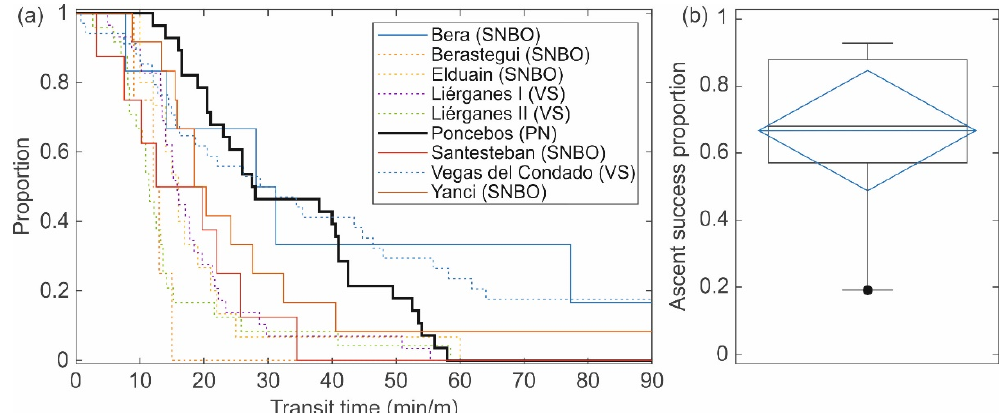
9 of 18 Figure 3. Numerical simulation of the fishway. ( a ) Pool depth of 1.8 m. ( b ) Pool depth of 5 m; dotted red line indicates the depth of 1.8 m. 3.2. Fish Response Regarding the comparisons between the two fish groups, there were no significant differences in biometric characteristics (Table 2) nor in the passage metrics (attempt per- centage, passage success, height exceeded, and transit time p -values = 0.463, 0.602, 0.568, and 0.949, respectively). Considering this, to study the following relations and increase the number of data, both groups were merged and analyzed together. The attempt percentage was 86% (59/69), with a mean number of attempts of 2.2 per fish. The ascent success was 19% (11/59), and the smallest trout with a registered success had a body length of 22 cm. The median transit time per meter of ascended height was